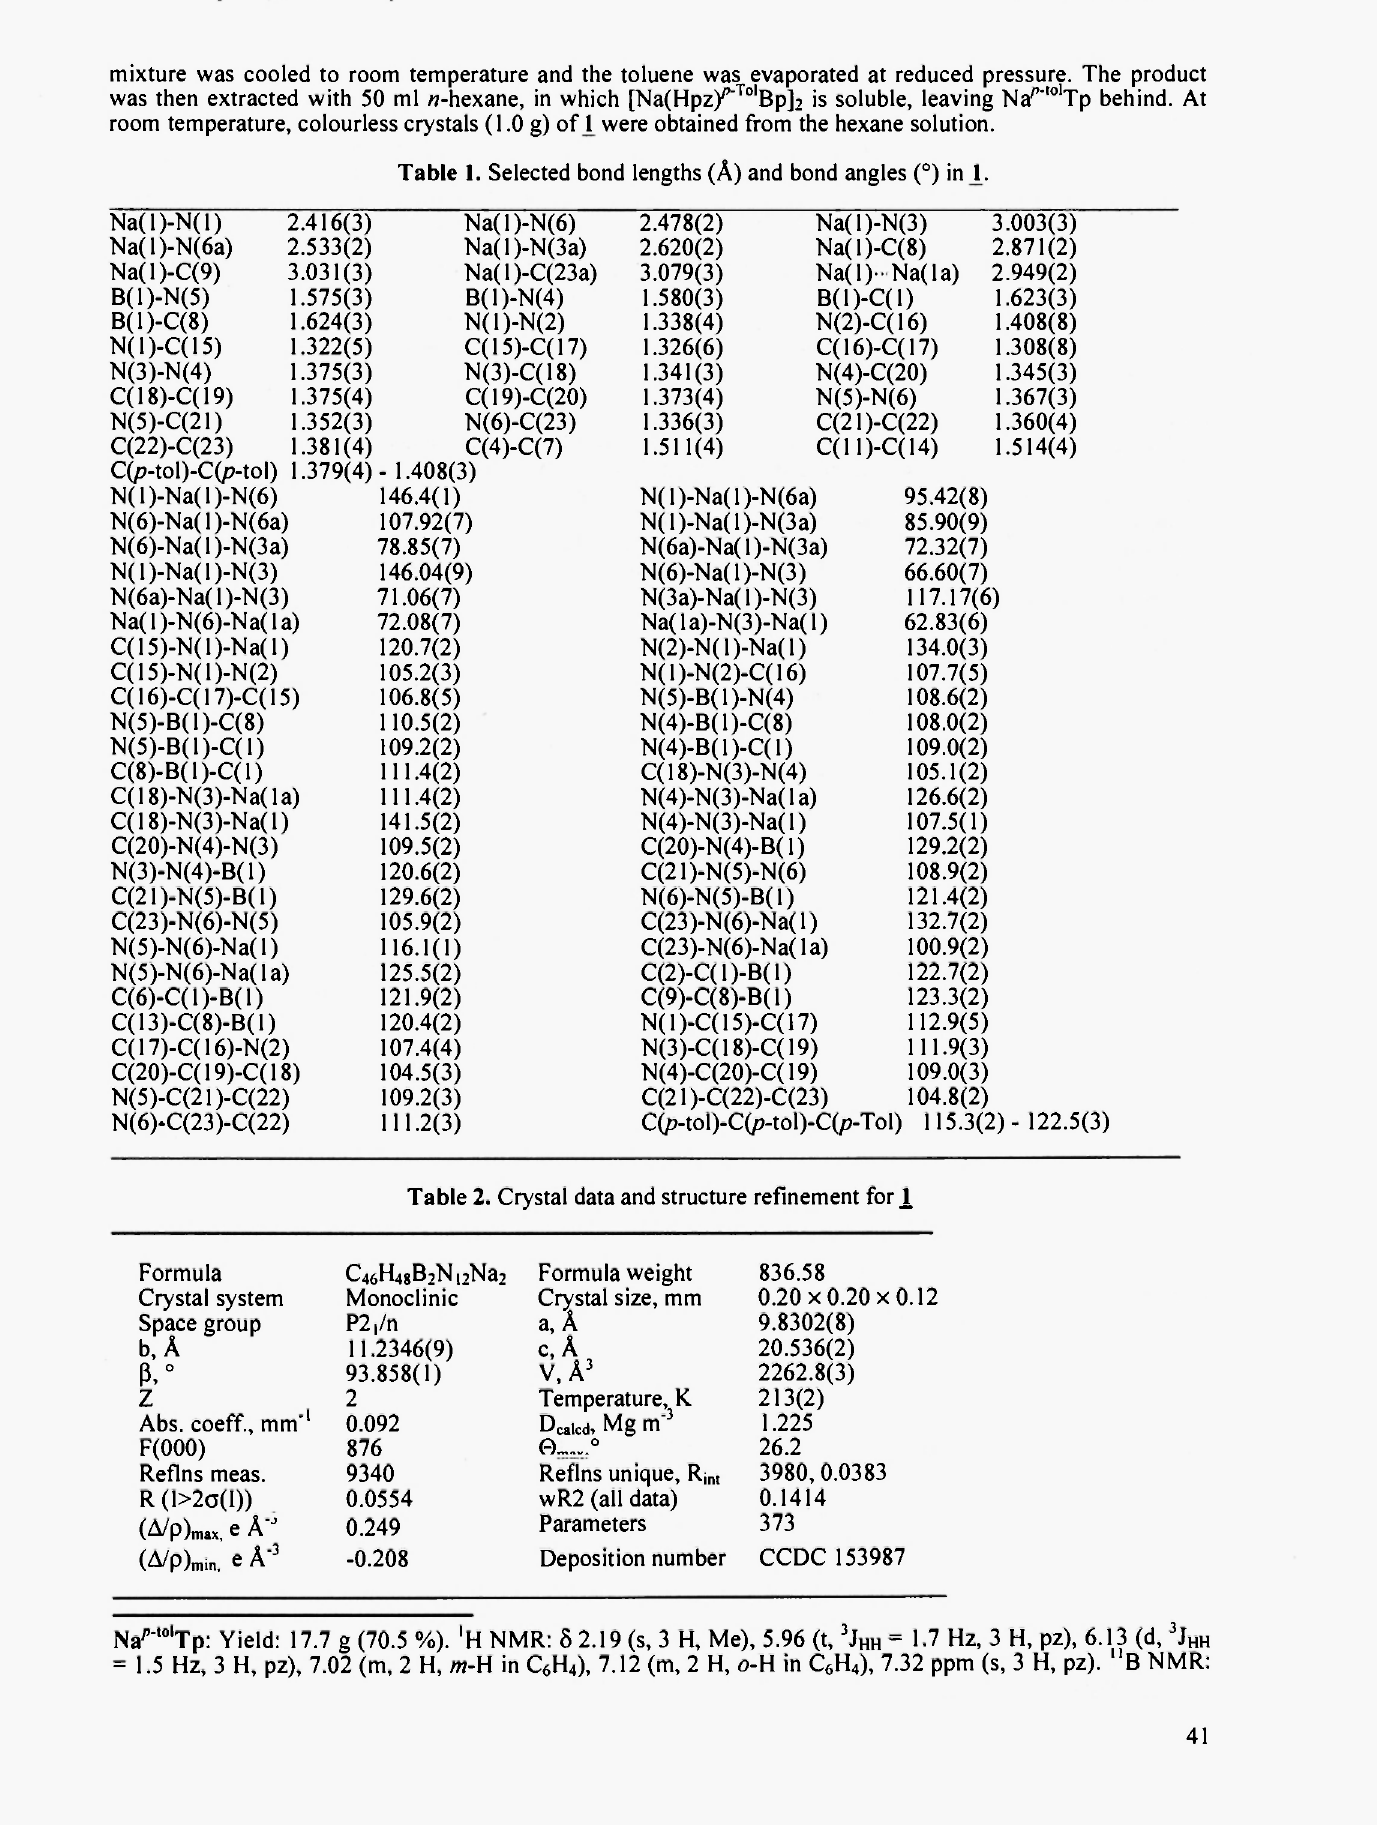
Table 1. Selected bond lengths (A) and bond angles (°) in L